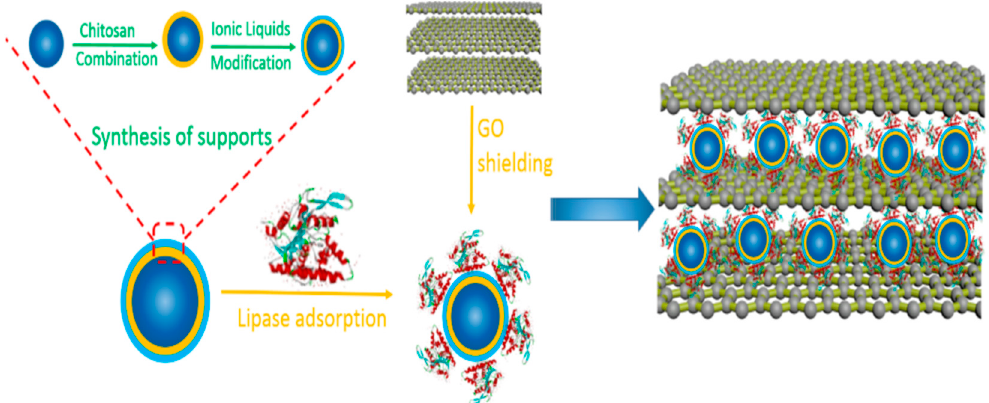
Figure 7. Schematic for the preparation of immobilized lipase on poly(4-((2-(dimethylamino)ethyl)amino)- 4-oxobut-2-enoic acid-alt-isobutylene) (pID)-grafted silica nanoparticles. Reprinted from Zhang et al. [63], with permission from Elsevier. Copyright (2019) Elsevier B.V.